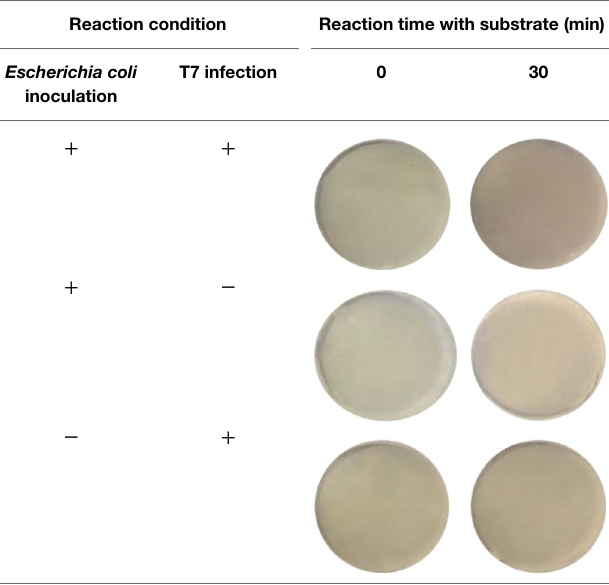
TABLE 3 | Filters with 5-h enriched 10 CFU/ml E. coli BL21 and 30 min with and without infection with bacteriophage T7-ALP in TSB-spinach and bacteriophage T7-ALP in TSB-spinach after enzymatic reaction with NBT/BCIP for 0 and 30 min. Reaction